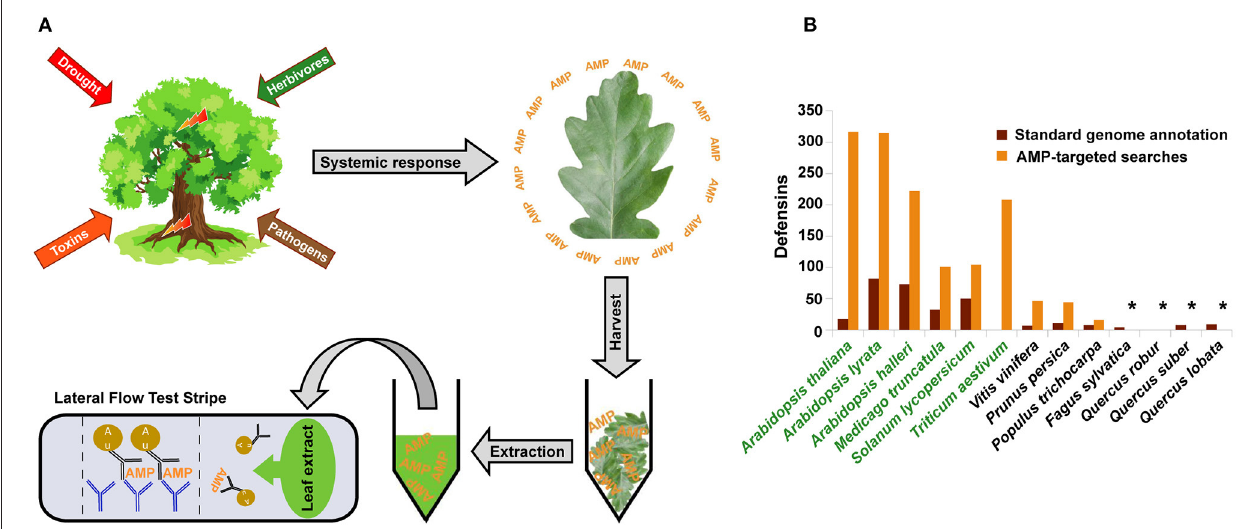
FIGURE 1 | Plant defense proteins as potential markers for an early detection of forest diseases. (A) Schematic representation of a plant proteins-based test system. In trees, visible symptoms often appear years after disease induction. At molecular level, plants develop a systemic defense response from hours to days after onset of infection or stress. Plant defense proteins, such as antimicrobial peptides (AMP), can be detected in leaf extracts using Lateral-Flow-Test (LFT) with two specific antibodies. The first anti-AMP antibody forms a mobile complex with an AMP molecule and flows in the direction of the stripe region containing an immobilized second anti-AMP antibody capturing this complex. If AMPs are present, the color of the corresponding stripe region changes because of macroscopic gold particles bound to the mobile anti-AMP antibody. Using LFTs, tree diseases can be detected at an early asymptomatic stage. In addition, more detailed results are conceivable with a multiple-readout test stripe containing multiple test lines with two antibody pairs against different antigens, e.g., one antibody pair against a general stress-marker and another against an AMP characterized by a narrow spectrum of antimicrobial activity. More technical details of LFTs are described elsewhere (Yetisen et al., 2013). (B) Current state of knowledge on defense proteins in woody plants: The case of defensins. Total number of defensin and defensin-like genes predicted using standard homology-based genome annotation (brown) and AMP-targeted (orange) pipelines are given for selected herbaceous and woody plant species (species names in green and black, respectively). Information about the number of genes identified using the AMP-specific approaches is available for A. thaliana , A. halleri, and A. lyrata (Silverstein et al., 2005), M. truncatula (de Bang et al., 2017), T. aestivum (International Wheat Genome Sequencing, 2018), V. vinifera (Giacomelli et al., 2012), S. lycopersicum , P. persica, and P. trichocarpa ( Liu et al., 2017). Stars indicate species, for which corresponding information is not